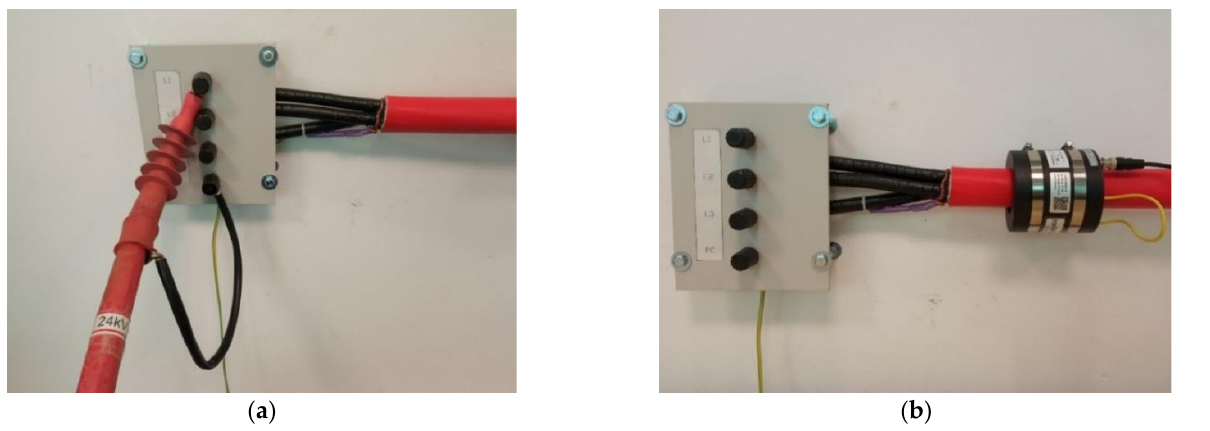
Figure 1. Different types of couplers connected to a physical MV cable: ( a ) Capacitive coupler; ( b ) Inductive coupler.